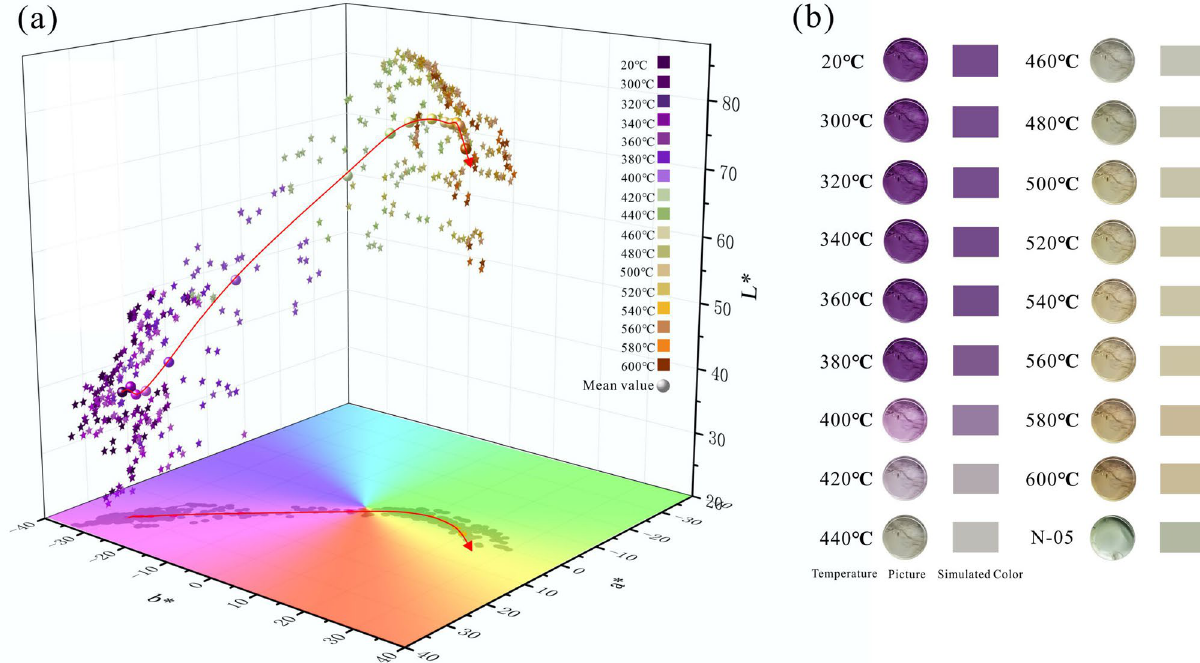
Figure 4. The color and distribution of amethyst at different temperatures (a) Color parameters of the amethyst at different temperature in CIE1976 L*a*b* uniform color space. (b) The pictures of amethyst in different temperatures and the simulated color. The figures were drawn using the OriginPro 2017C Beta b9.4.1.268 (https ://www.Origi nLab.com) and CorelDRAW Graphics Suite X8 2016 18.0.0.405 (https ://www.corel .com).